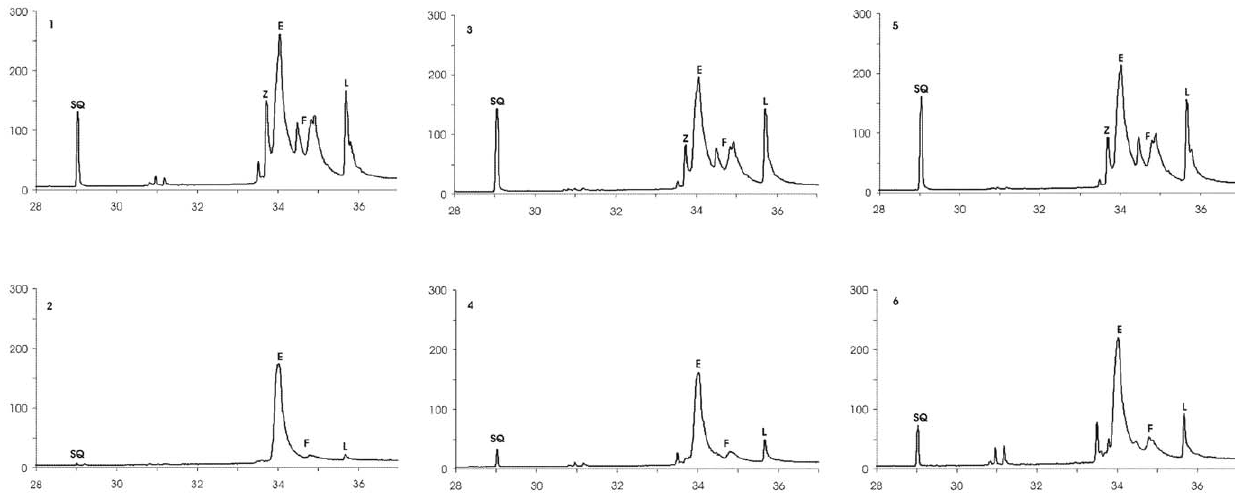
Figure 3. GC/MS analysis of sterols from yeast cells. Changes in the level of ergosterol and its precursors in cells treated with simvastatin depend on the mutation in the hHMGR gene. Panels 1, 3, 5 sterols from cells harbouring the wild-type yeast, or the wild-type or mutated hHMGR gene, respectively. Panels 2, 4, 6 sterols from cells treated with simvastatin harbouring the wild-type yeast, or the wild-type or mutated hHMGR gene, respectively. SQ squalene, Z zymosterol, E ergosterol, F fecosterol and isomers, L lanosterol and cholesta-8,14-dien 3-ol, 4.4-dimethyl (3 ’ , 5 ; ).